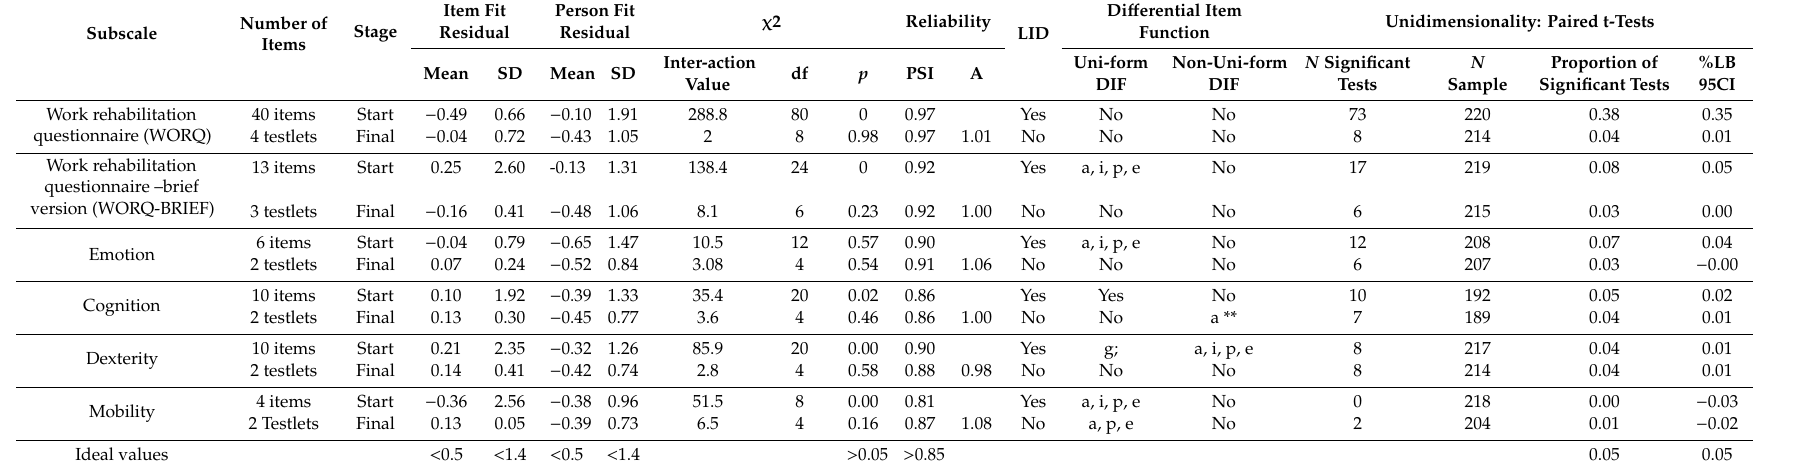
Table 3. Rasch analysis summary for all tested sum-scores and subscores of